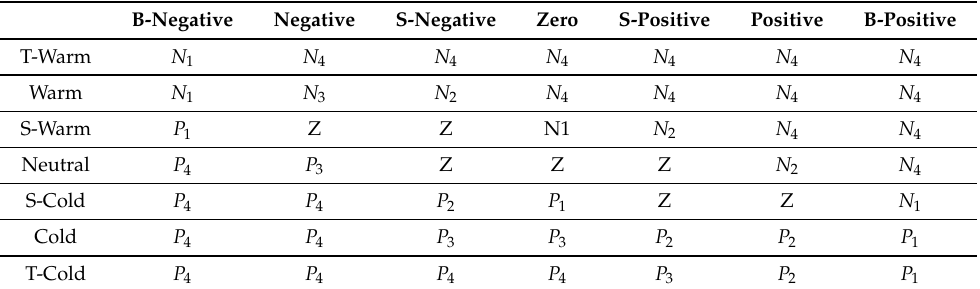
Table 3. Rules of fuzzy temperature control system based on PMV and ∆ PMV